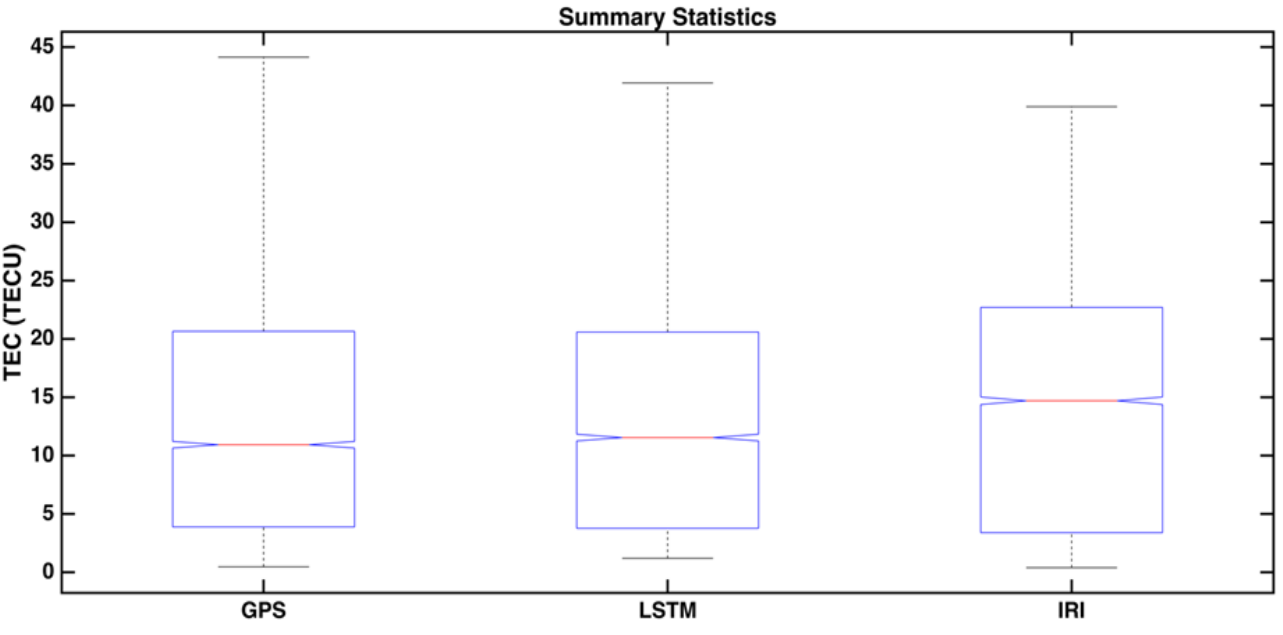
Figure 9. Summary statistics of the TEC data for the observed GPS data with IRI and deep learning method LSTM.